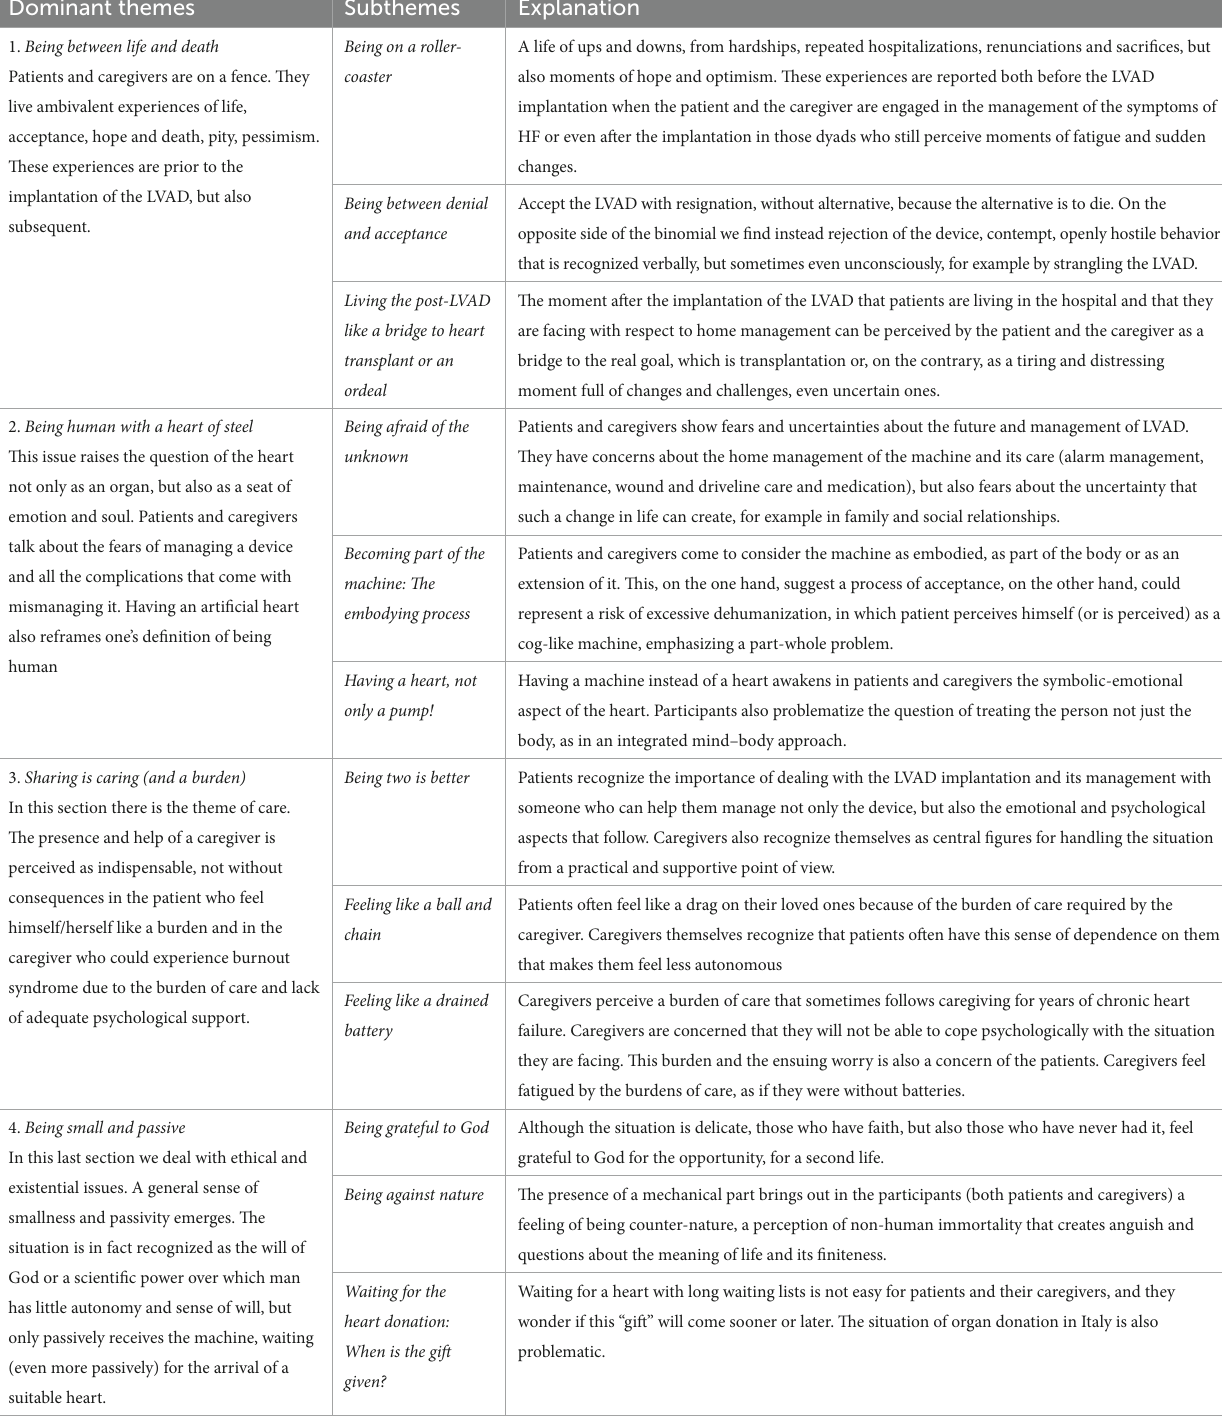
TABLE 2 Dominant themes, subthemes, and